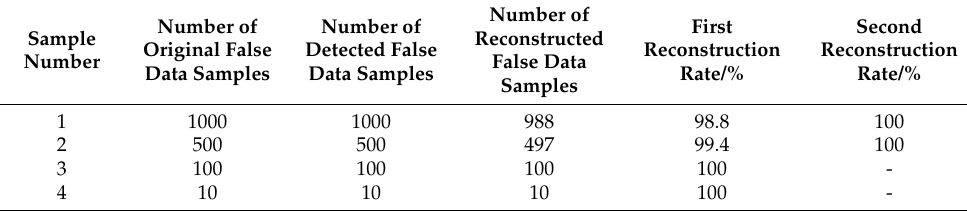
Table 4. Evaluation of false data reconstruction effect.